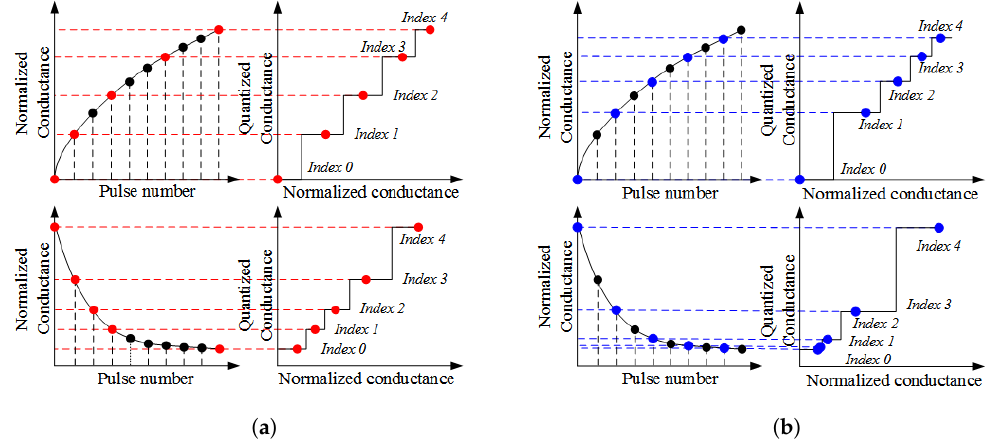
Figure 6. Conductance quantization ( a ) proposed and ( b ) typical methods. In ( a , b ), the top is the potentiation graph and the bottom is the depression graph. In addition, the left is the normalized conductance for the identical pulse, and the right is the quantized conductance for the normalized conductance. The index N means the Nth quantization